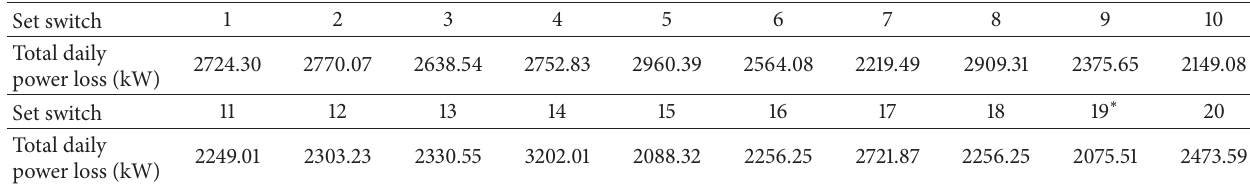
Figure 4: 33-bus test system with DG at buses 6, 18, and 22. Table 1: Results of total power loss evaluation for all sets switch obtained in Part